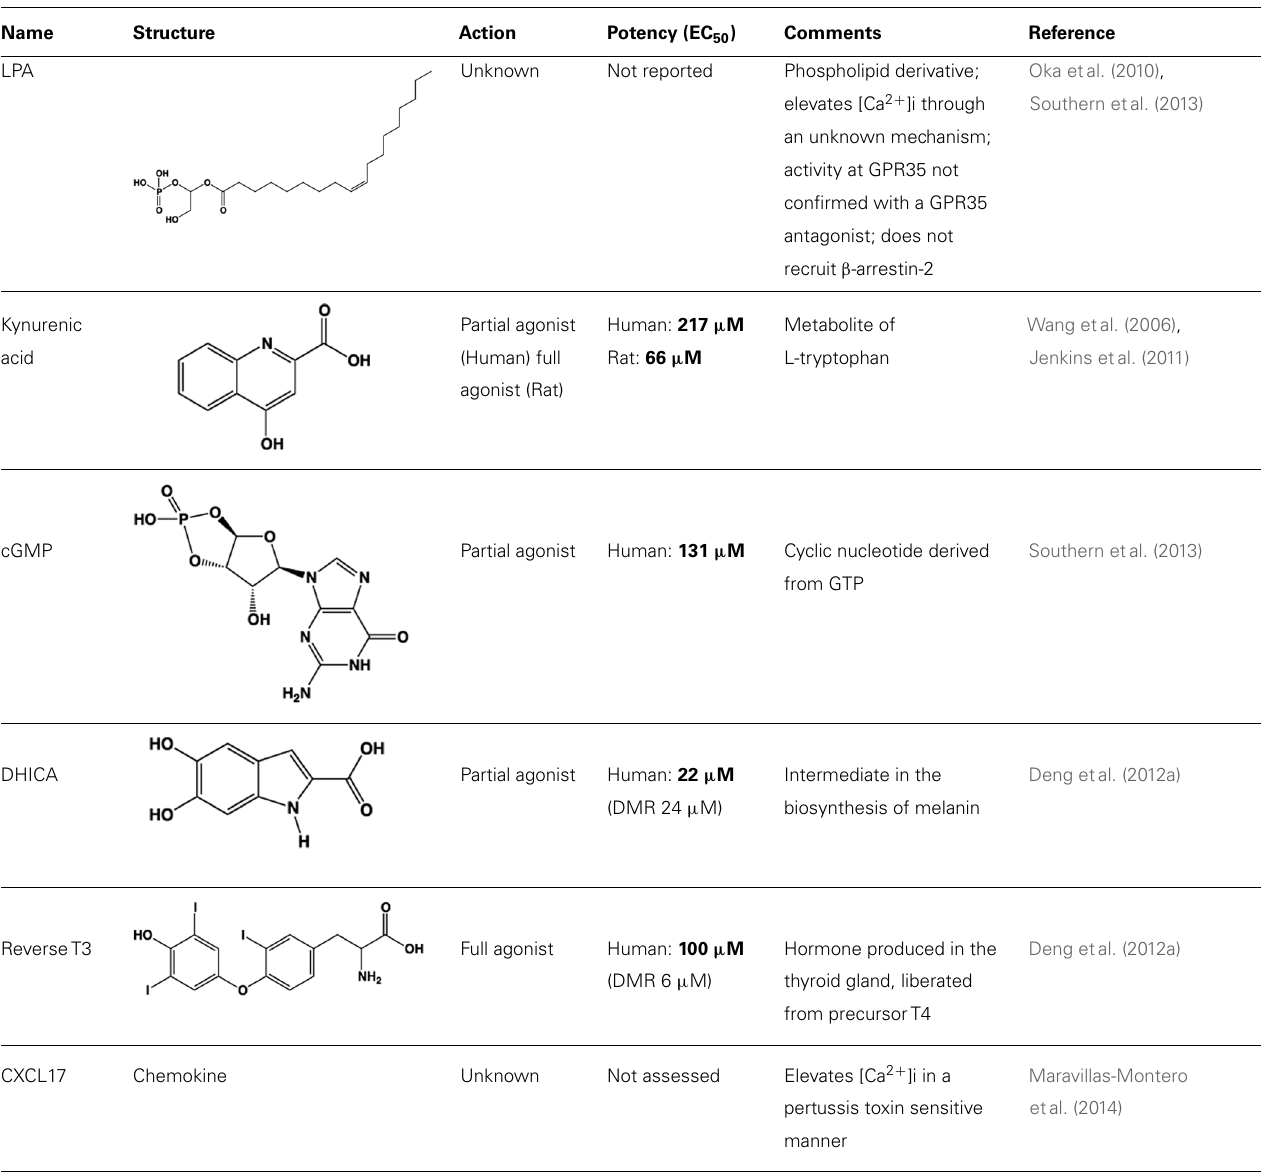
Table 1 | Reported endogenous ligands with activity at